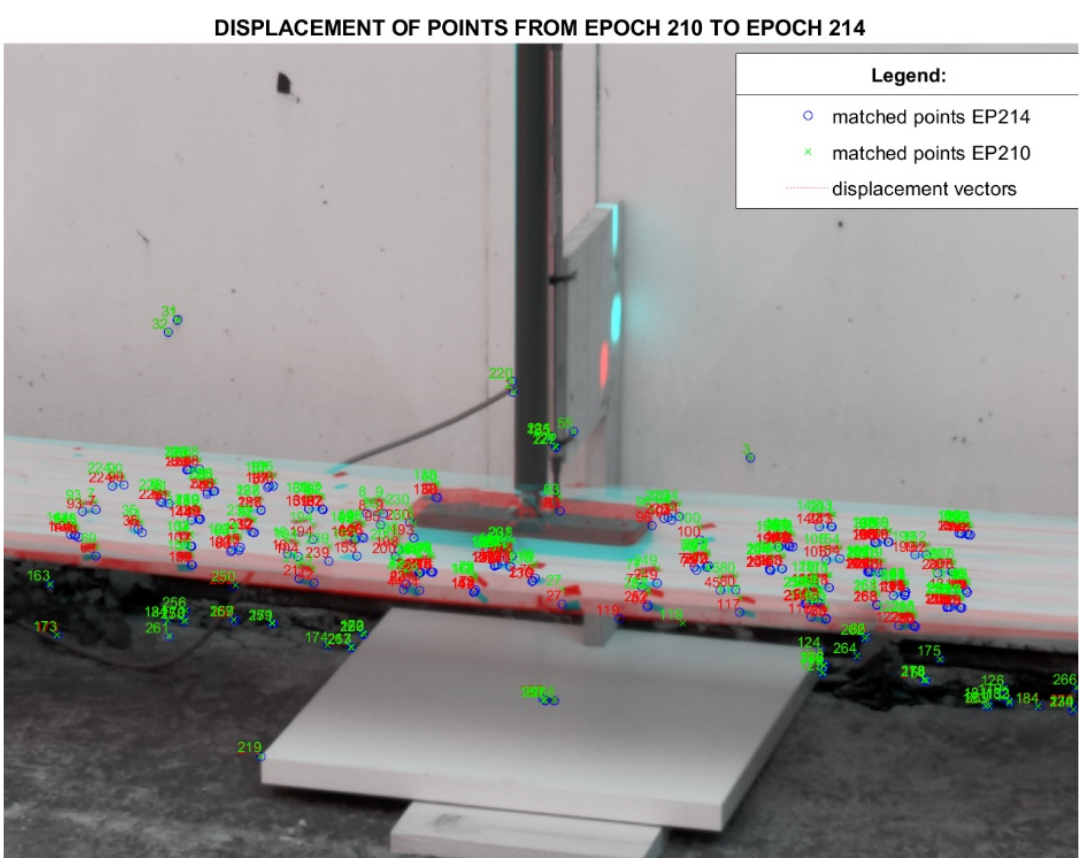
Figure 11. Example of plotted identical points and image displacement vectors between two epochs (Source: Own compilation).